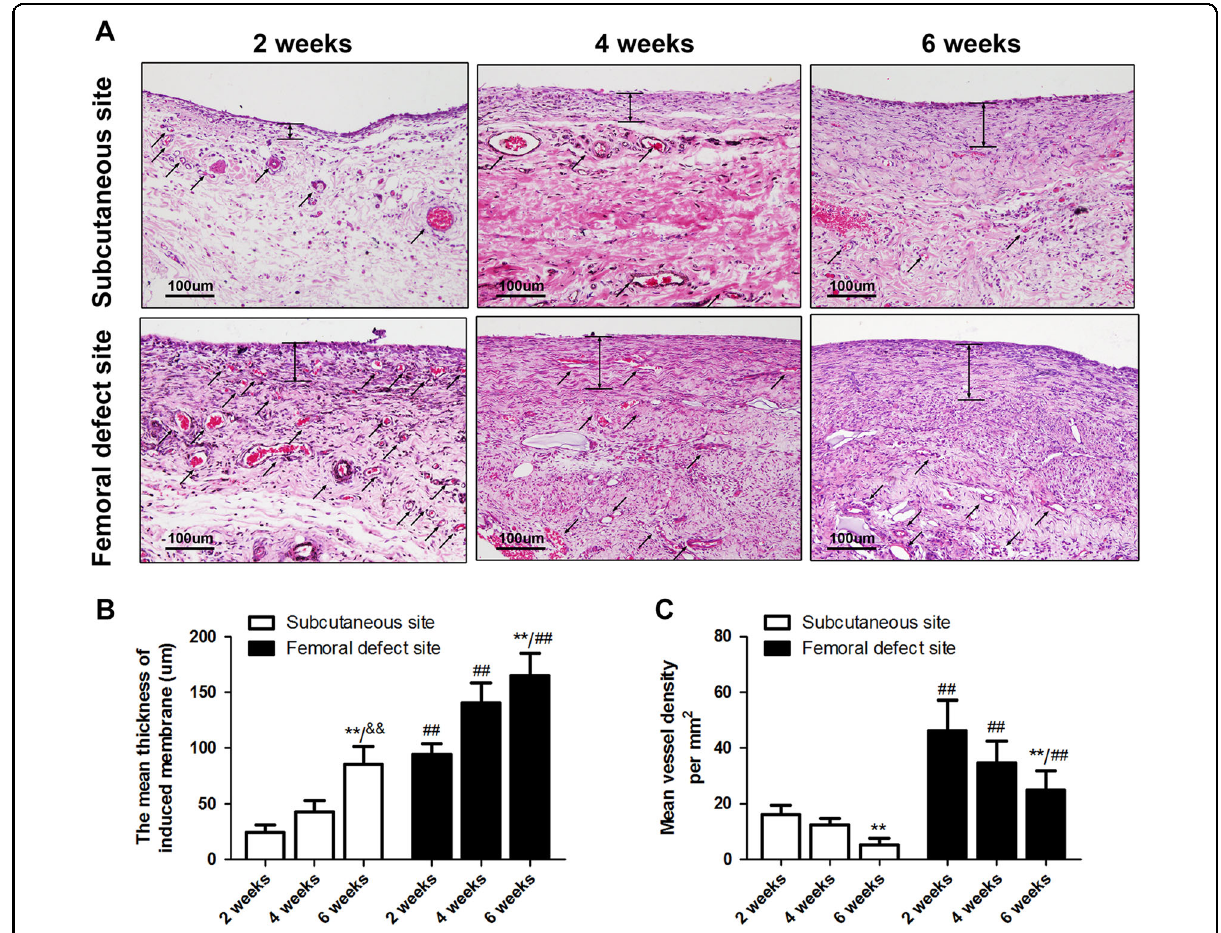
Fig. 2 Characteristics of the induced membrane formed in the subcutaneous site and femoral defect site. a H&E results of the induced membrane formed in the subcutaneous site and femoral site at 2, 4, and 6 weeks (scale bar: 100 μ m, black arrows indicate microvessels). b Quantitative results for membrane thickness. c Quantitative results of vessel density in induced membranes. The data in the fi gures represent averages ± S.D. Signi fi cant differences between different groups are indicated as ** P < 0.01, compared with 2-week induced membrane in the subcutaneous site and femoral defect site, respectively; && P < 0.01, compared with 4-week induced membrane in the subcutaneous site; ## P < 0.01 compared with the same time point for induced membrane in the subcutaneous site; for each group, n =